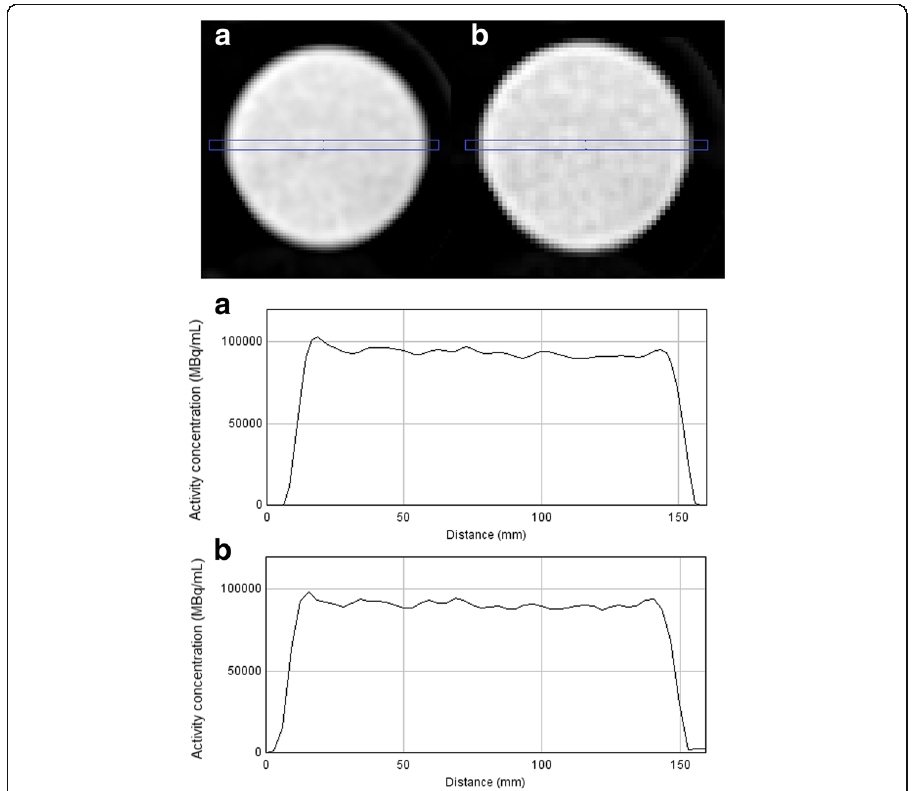
Fig. 5 Top: reconstructed images (sum of four slices) of the uniform compartment of the Jaszczak phantom, for the clinical reconstruction ( a ) and the research reconstruction ( b ) algorithm. Bottom: activity concentrations profile across the summed slices as indicated in the displayed images (in